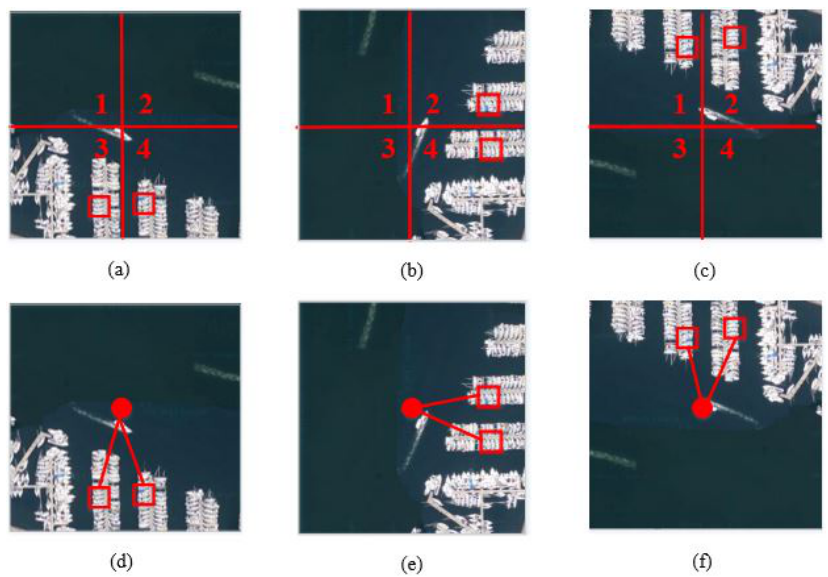
Figure 20. SPM ( a , b , c ) vs.the proposed approach ( d , e , f ). Here ( a , d ) represent the original images, ( b , e ) the images rotated by 90 ◦ , and ( c , f ) vertically flipped